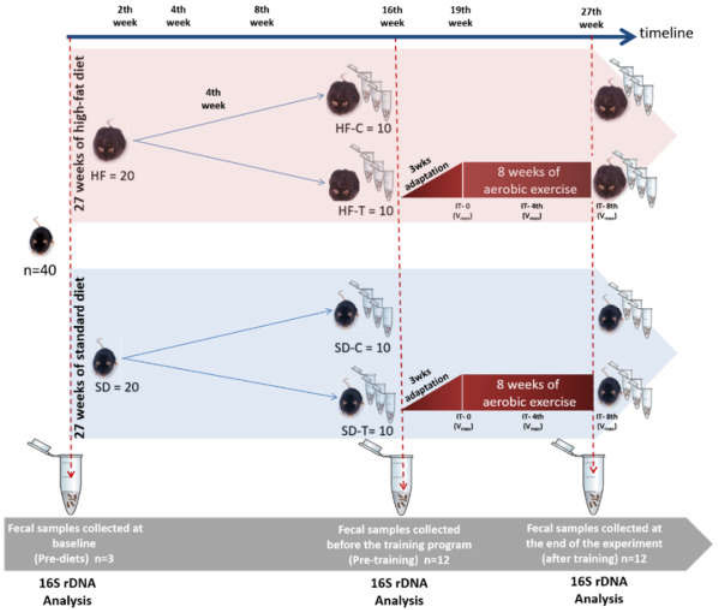
Figure 1. Experimental design. C57BL6 male mice ( n = 40) were divided into two groups: high fat (HF) and standard diet (SD). Afterward, animals were subdivided into four groups: standard diet control (SD-C, n = 10); standard diet trained (SD-T, n = 10); high-fat control (HF-C, n = 1); and high-fat trained (HF-T, n = 10). IT-0 (incremental test before training), IT-4 (IT at the 4th week of training), IT-8 (IT at